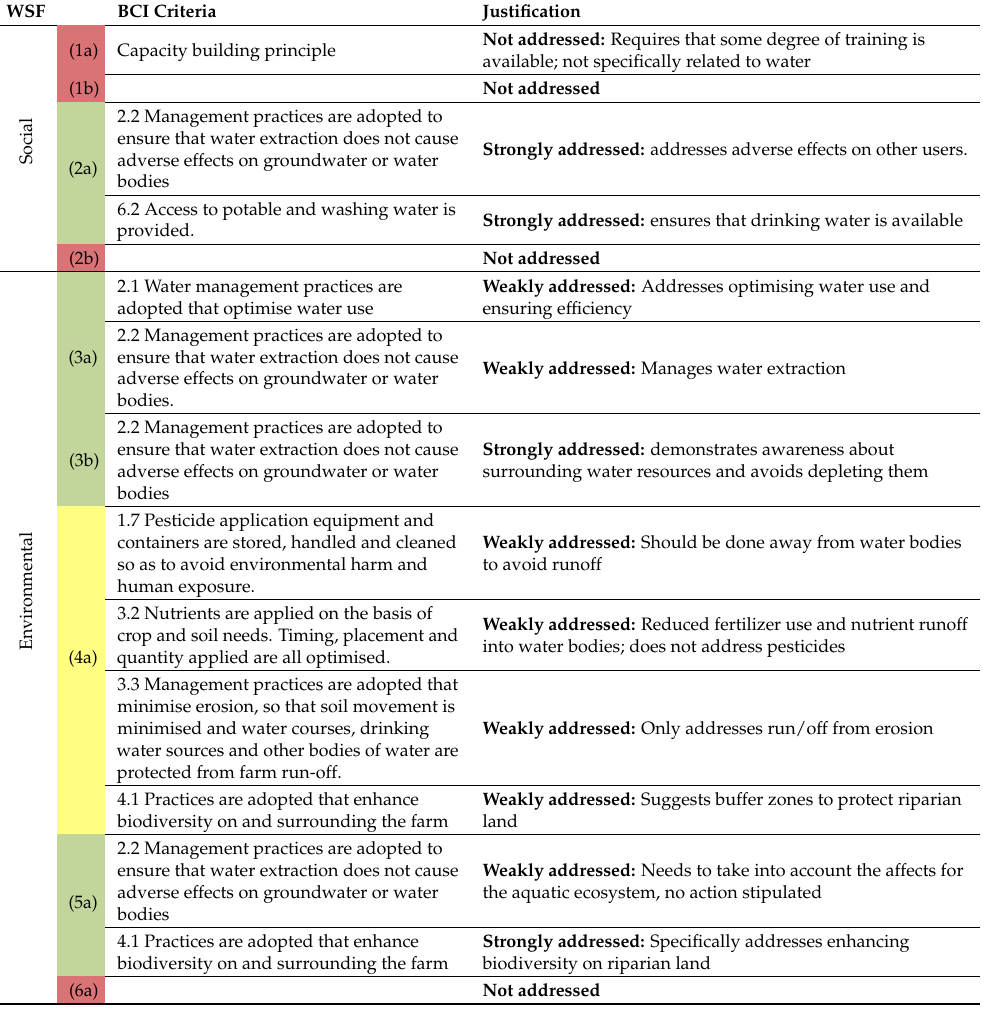
Table A2. Better Cotton Initiative